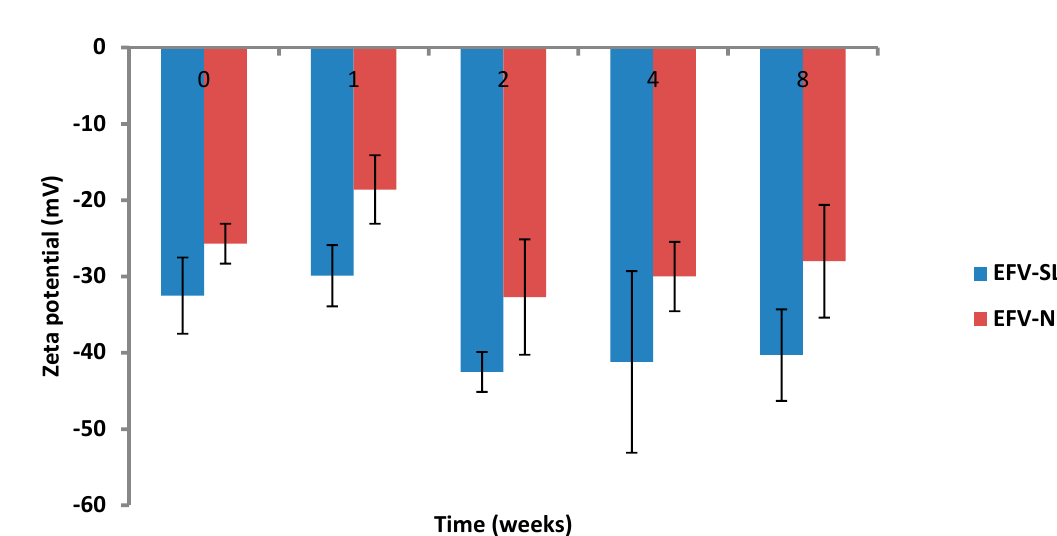
Pharmaceutics 2019 , 11 , x FOR PEER REVIEW Figure 15. Zeta potential of SLN and NLC following storage at 25 ◦ C / 60% RH. Figure 15. Zeta potential of SLN and NLC following storage at 25 °C/60% RH .